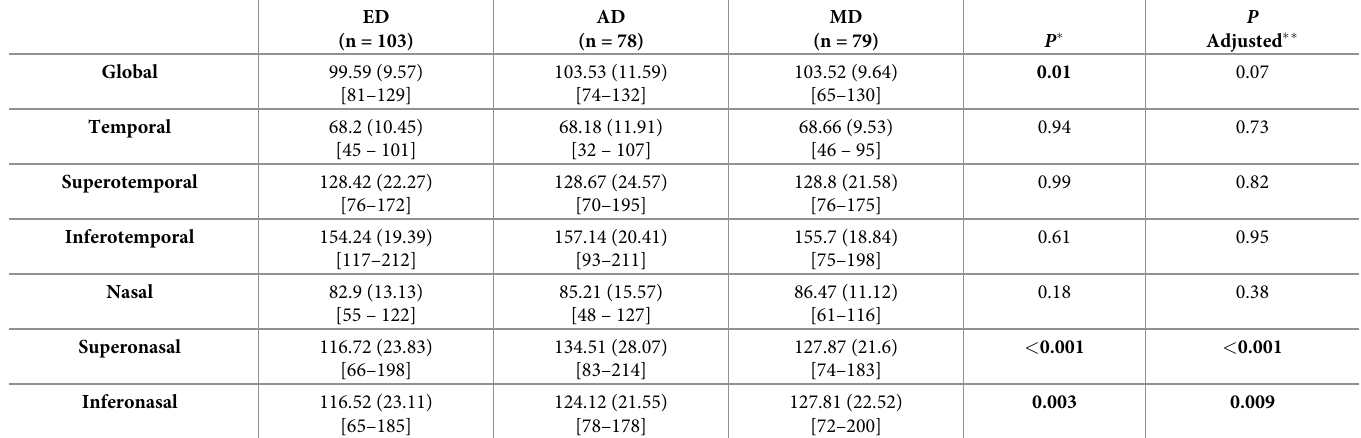
Table 3. Comparison of global and sectorial retinal nerve fiber layer thickness (RNFLT) measurements by race. ED (n = 103)